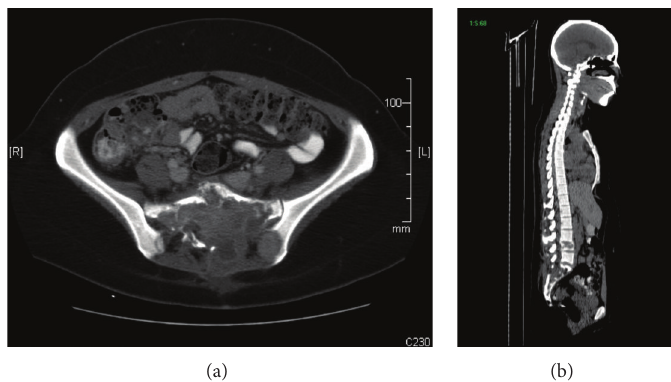
Figure 1: CT Scan showing tumor invasion of sacrum: left and right surrounding parasacral soft tissue (a), and L4 vertebral body (b).